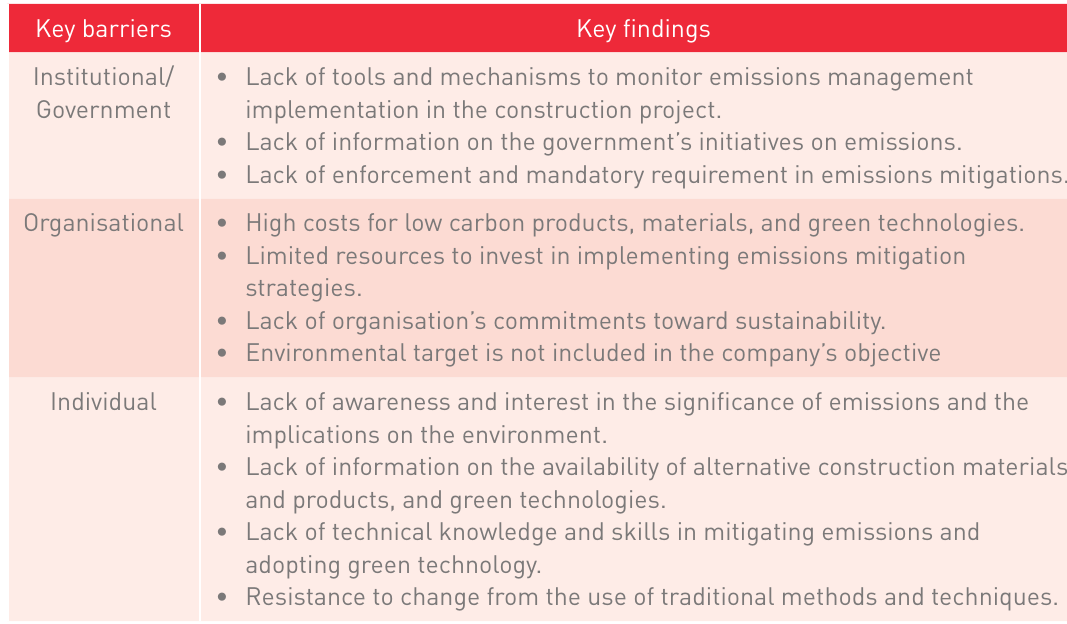
Summary findings of key challenges hindering successful emissions management